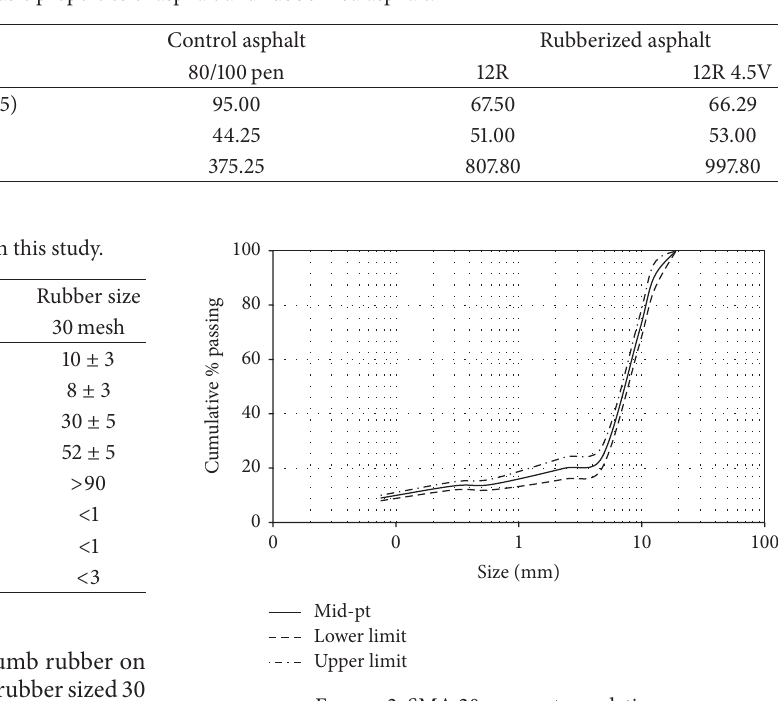
Figure 2: SMA 20 aggregate